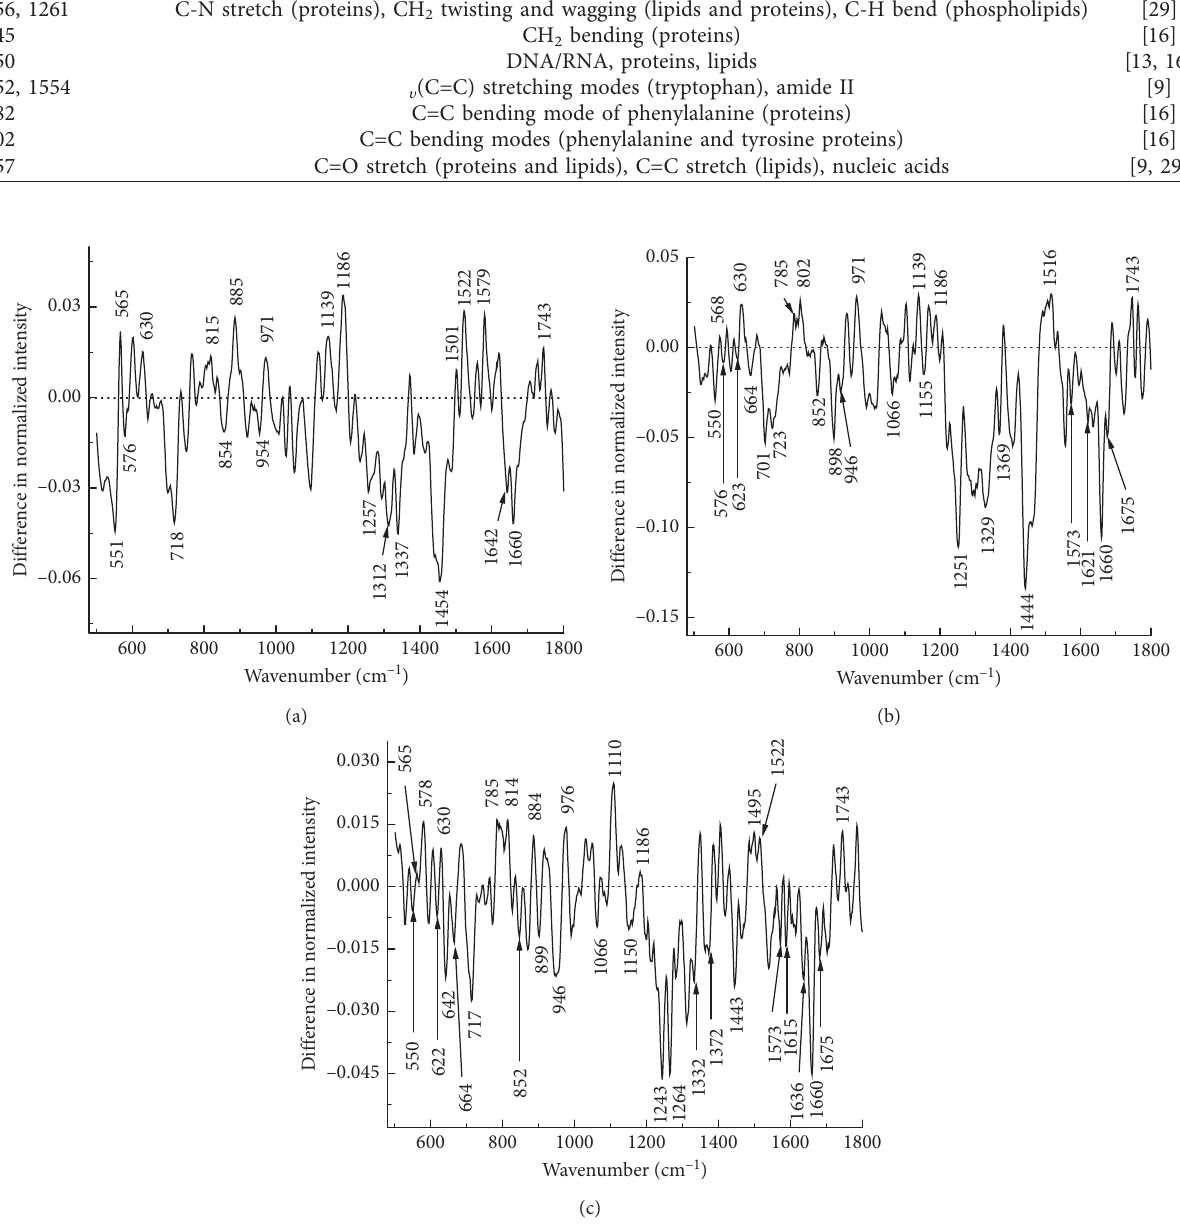
Figure 3: Difference spectra between the normalized mean spectra of PC3 and PNT1a cells for (a) stage 1 (48 hours), (b) stage 2 (72 hours), and (c) stage 3 (96 hours) spectral measurements. It is observed the PC3 samples have prominent spectral markers at 566 ± 0.70 cm − 1 , 630cm − 1 , 972 ± 1.17cm − 1 , 1186cm − 1 , 1520 ± 1.41cm − 1 , and 1743cm − 1 . The PNT1a samples have prominent spectral markers at 550 ± 0.23cm − 1 , 719 ± 1.31 cm − 1 , 852 ± 0.47 cm − 1 , 948 ± 1.88 cm − 1 1250 ± 2.86cm − 1 , 1332 ± 1.64cm − 1 , 1450 ± 2.20cm − 1 , and 1660cm − 1 .